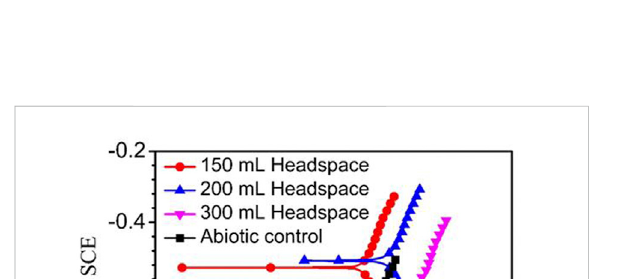
the electrochemical corrosion data trends, with the exception of OCP, are consistent with the weight loss trend, all pointing to more sessile cells for faster MIC, which is characteristic of EET-MIC.